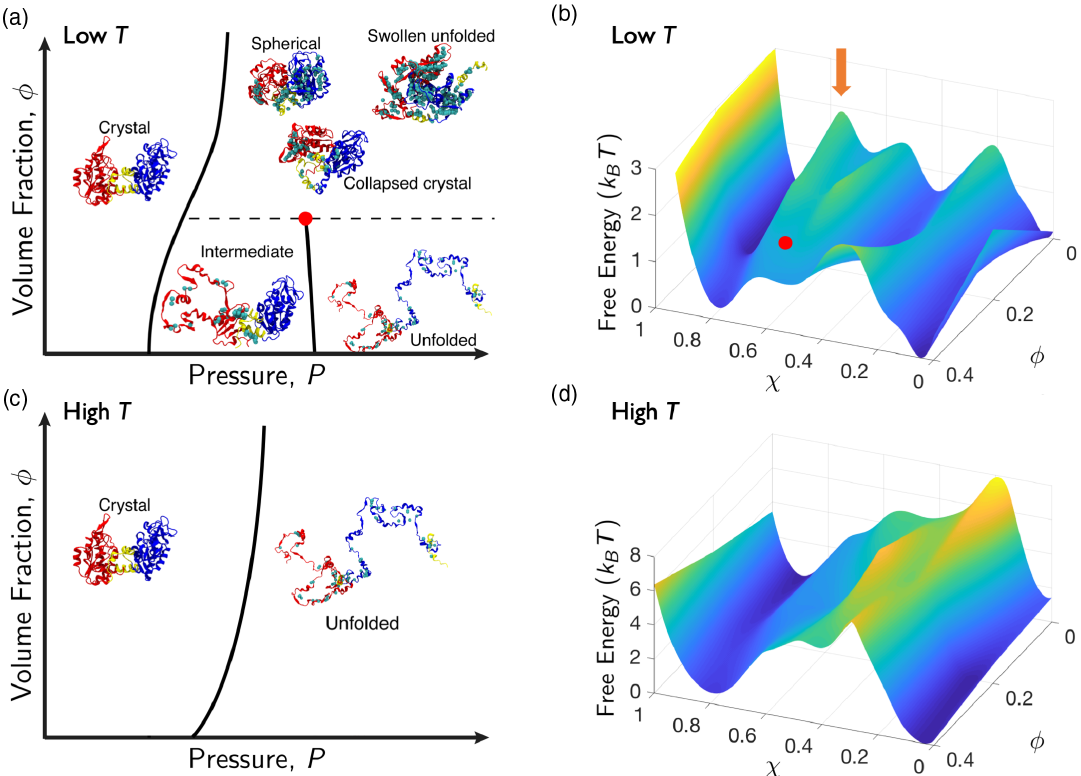
FIG. 2. Solvation and crowding give rise to an intricate phase diagram of PGK. (a),(c) Schematics of PGK ’ s behavior in the crowding volume-fraction-pressure ( ϕ - P ) phase plane and (b),(d) corresponding free energy with respect to the overlap χ and crowding volume fraction ϕ at the folding pressure at low (a),(b) and high (c),(d) temperatures. Solid lines represent the division between distinct configurational phases that are separated by a free-energy barrier from simulations at ϕ ¼ 0 , 0.2, and 0.4 and pressures from σ 3 P= ϵ 0 ¼ σ 3 ≈ 76 MPa). The dashed line (a) represents a continuous transition along ϕ , and red dots (a),(b) represent an 10 3 to 13 ( ϵ 0 = approximate position of the critical points. The orange arrow (b) marks the peak of the barrier that diminishes until it disappears after the critical point. Collapsed crystal, spherical, and swollen unfolded states are indistinguishable in terms of free energy. These configurations are reconstructed from coarse-grained models to all-atomistic protein models for illustration purposes using SCAAL (side chain- C α to all-atom method) [29]. The N and C domains and hinge are in red, blue, and yellow, respectively. A cyan sphere is inserted in between residues to show water-mediated